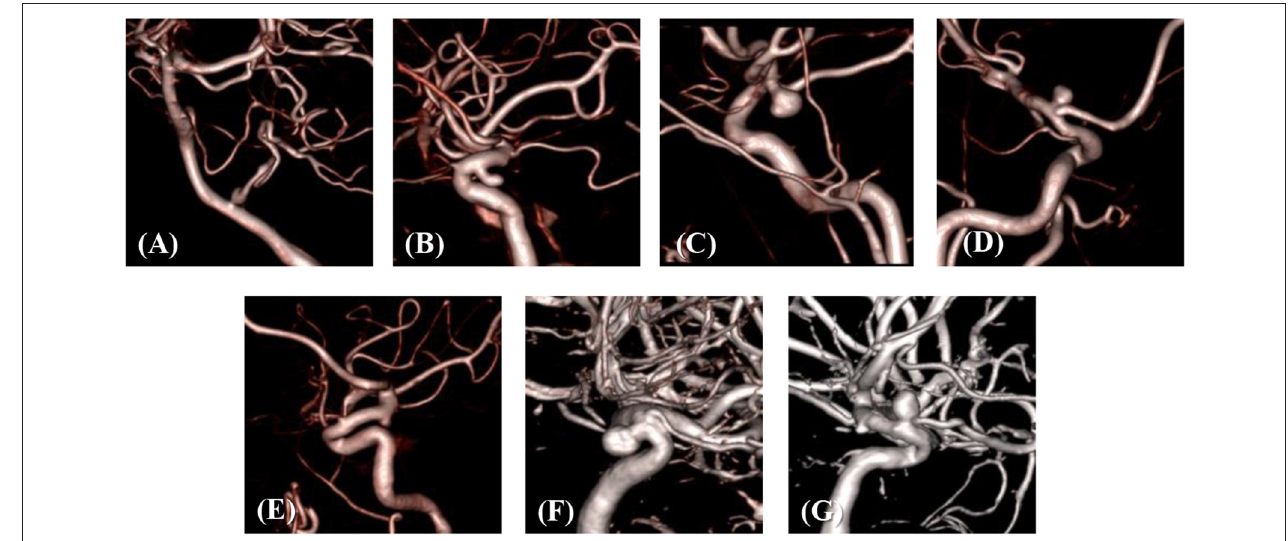
TABLE 1 | Types and size parameters for the patient-specific aneurysm cases.